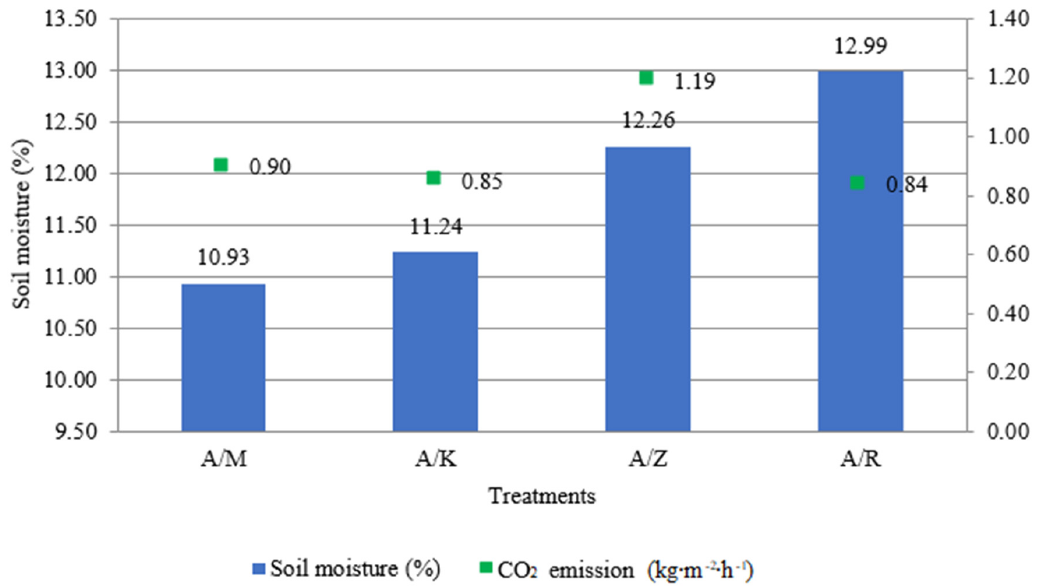
Figure 8. Average results of soil moisture (%), CO 2 -emission (kg m − 2 · h − 1 ) by treatment on 28 July 2020 (Karcag). Note: A/Z: Unused/abandonment grassland treatment; A/M: mulch treat- ment; A/K: Mowing treatment; A/R: Grassland.